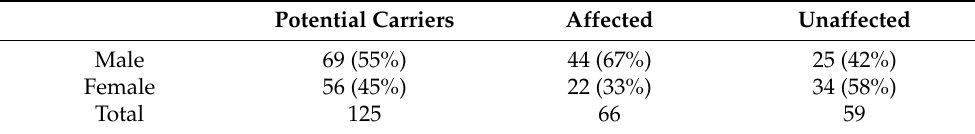
Table 4. Gender disbalance in patients harboring p.G90D in RHO from this and previous